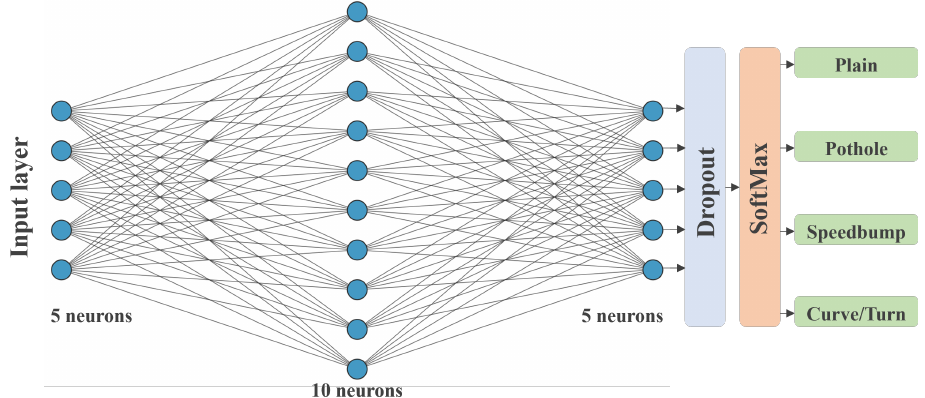
Figure 6. ANN network